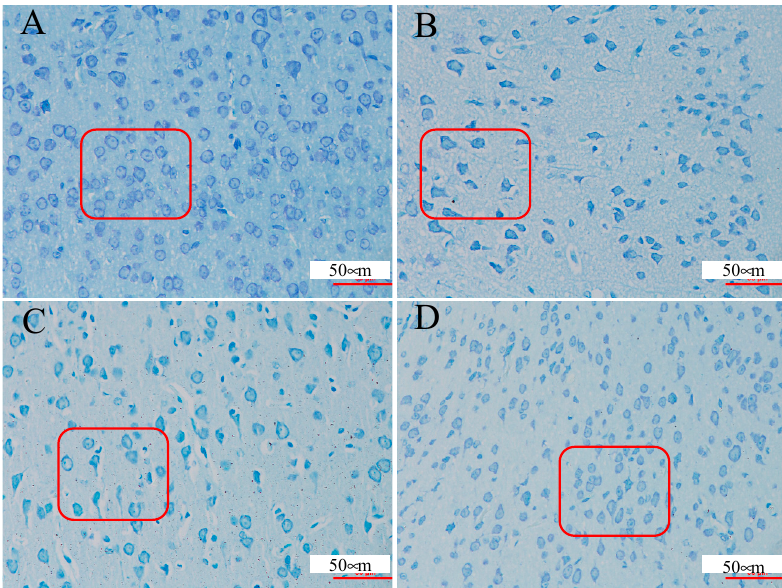
Figure 2. Amber rescues CA1 pyramidal neurons from seizure-induced damage as revealed by Nissl staining. ( A ) Control group; ( B ) Model group (PTZ); ( C ) PB group (PTZ + Phenobarbital); ( D ) Amber group (PTZ + amber). Photomicrographs show sample CA1 subfields (magnification, ×400) in the coronal plane for each treatment group. A damaged cell body is indicated by red frame. These signs of neural damage were reduced by amber pre-treatment.